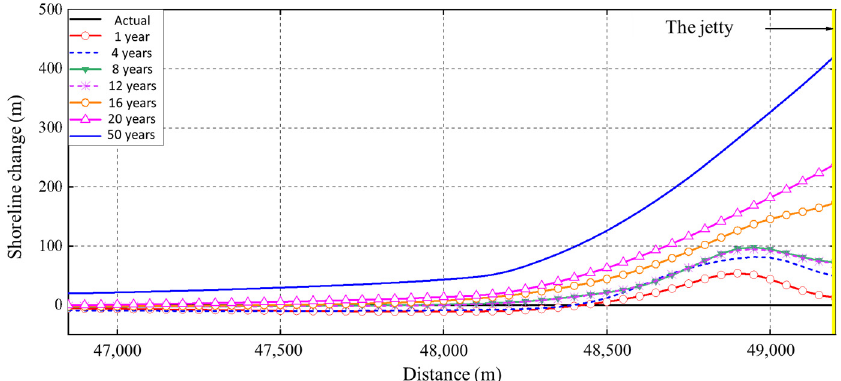
Figure 28. Shoreline change within 3 km in front of the Northern jetty. Table 4. Statistical table of shoreline change (m/year) after construction. Location Southern of Cua Dai Middle Shoreline Northern of Cua Lo